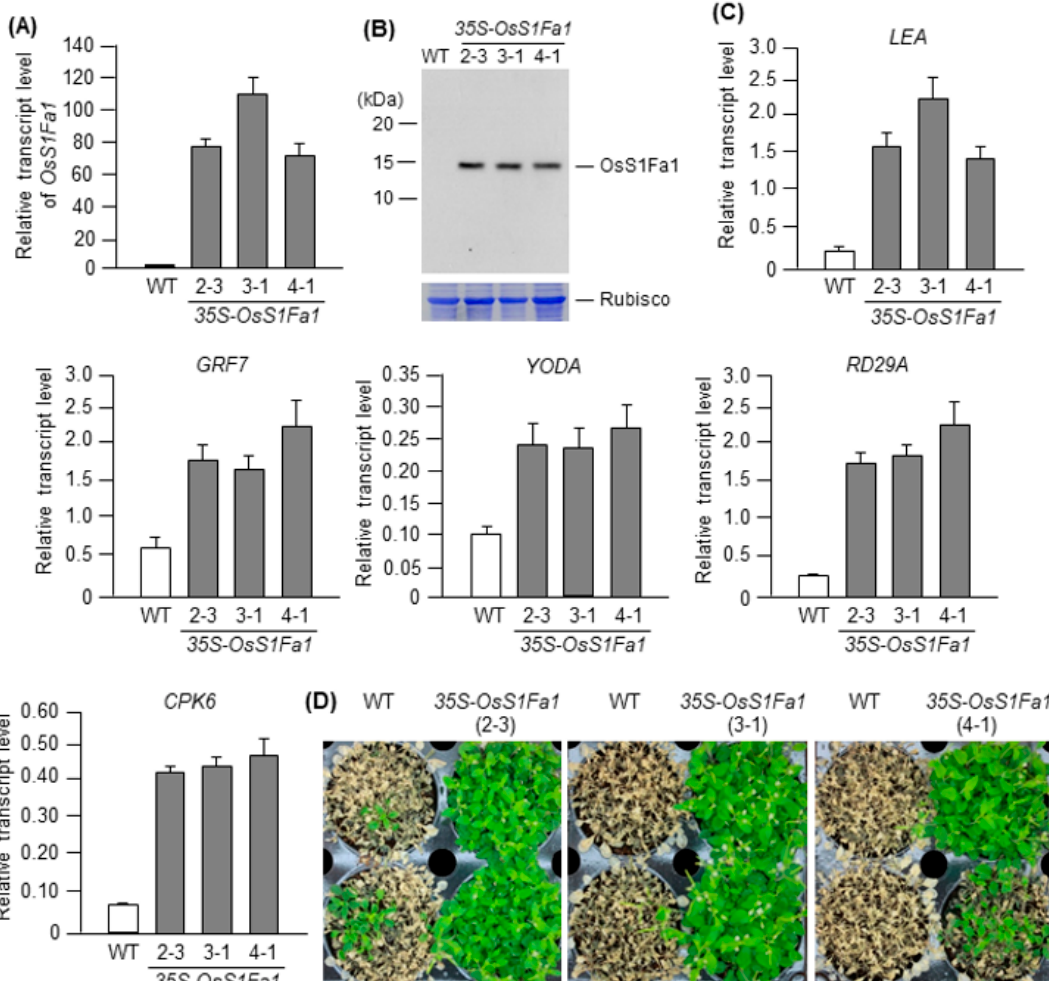
Figure 4. Generation and characterization of transgenic Arabidopsis lines overexpressing OsS1Fa1 . ( A ) RT-qPCR analysis of OsS1Fa1 expression in WT and transgenic Arabidopsis plants using gene-specific primers. Data represent mean ± SD ( n = 3). ( B ) Western blot analysis of the OsS1Fa1 protein in WT and transgenic plants using anti-OsS1Fa1 antibody. Total proteins were isolated from the same samples as those used in ( B ). Rubisco was used as the loading control. ( C ) Expression analysis of LEA , GRF7 , YODA , RD29A , and CPK6 in WT and transgenic plants by RT-qPCR using gene-specific primers. Total RNA samples used in this experiment were the same as those used in ( A ). Data represent mean ± SD ( n = 3). ( D ) Drought tolerance assay.